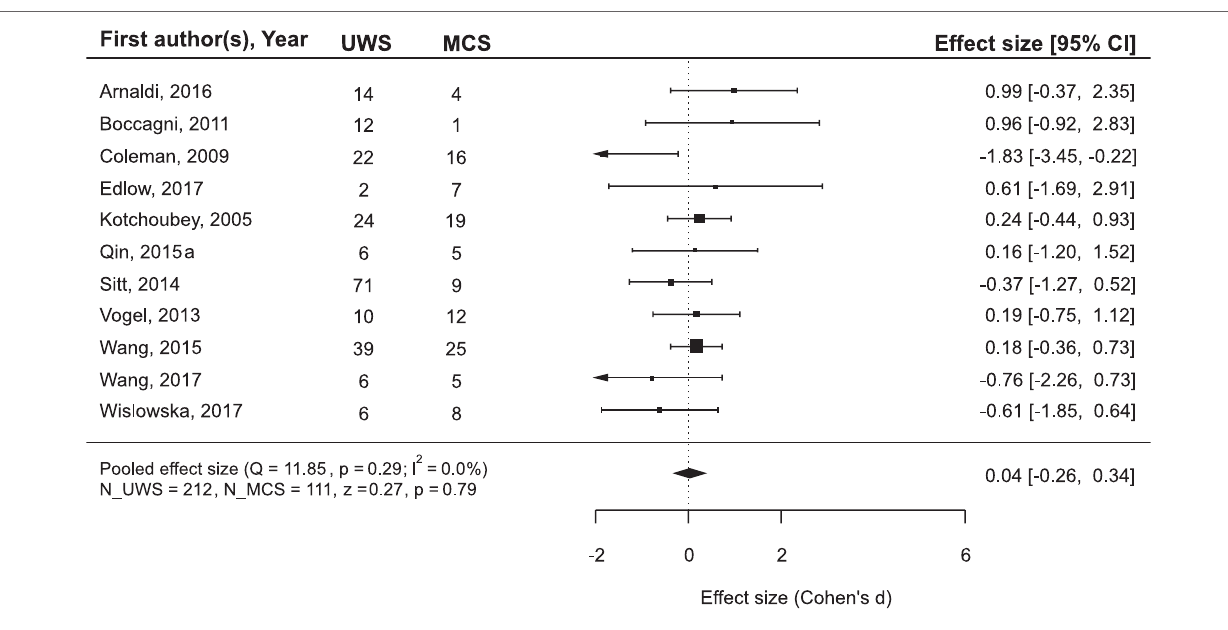
FiguRe 4 | The results of the meta-analysis for prediction of the outcome from the diagnosis. The criterion of improvement was “minimal improvement,” that is for UWS patients, it was the transition to MCS, and for MCS patients, at least the transition to Exit-MCS. As can be seen, with this improvement criterion the diagnosis does not predict outcome. The rest is the same as in Figure 3 .